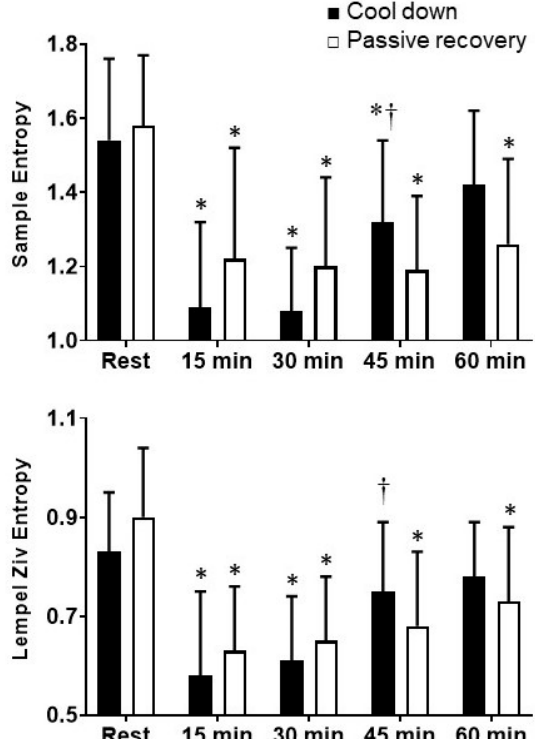
Figure 2. Sample entropy and Lempel–Ziv entropy at Rest and 15, 30, 45 and 60 min during recovery in moderately active individuals. Values are mean ± SD. * Significantly different from Rest ( p ≤ 0.05), † Significantly different from 30 min ( p ≤ 0.05).